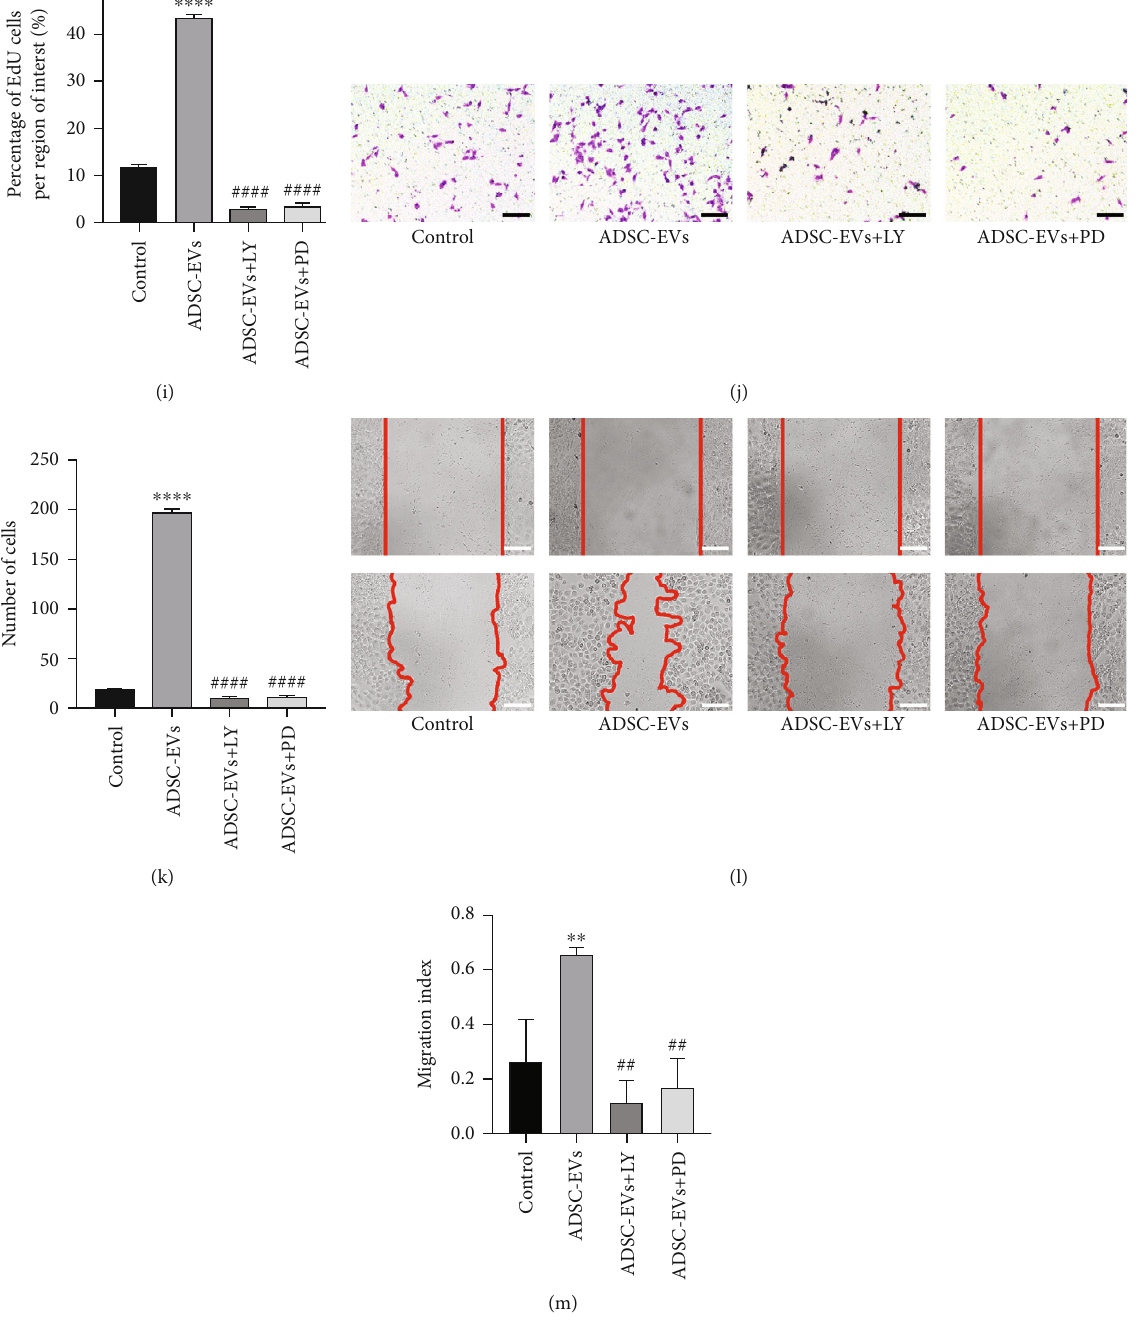
Figure 8: ADSC-EVs promote the proliferation and migration of cells via the PI3K/AKT and MAPK/ERK1/2 signaling. (a – c) Western-blot analysis of protein levels of p-Akt and p-ERK1/2 induced by di ff erent concentrations of ADSC-EVs. (d – g) LY294002 and PD98059 inhibit the activation of PI3K-AKT and MAPK-ERK1/2 induced by ADSC-EVs, respectively. (h, i) EdU assay showed that ADSC-EV-mediated RPMC proliferation was suppressed by inhibitors LY294002 and PD98059. (j, k) Transwell and (l, m) scratch assays showed that ADSC- EVs enhanced RPMC migration at 24h, but this e ff ect was signi fi cantly reduced by inhibitors LY294002 and PD98059. Bars, 100 μ m; data are represented as the mean ± SD . ∗ , vs. control group; n = 3 . ∗∗∗ P < 0 : 001 . # , vs. 25 μ g/mL group; ## P < 0 : 01 and ## P < 0 : 0001 . & , vs. 50 μ g/mL group; && P < 0 : 01 ; &&&& P < 0 : 0001